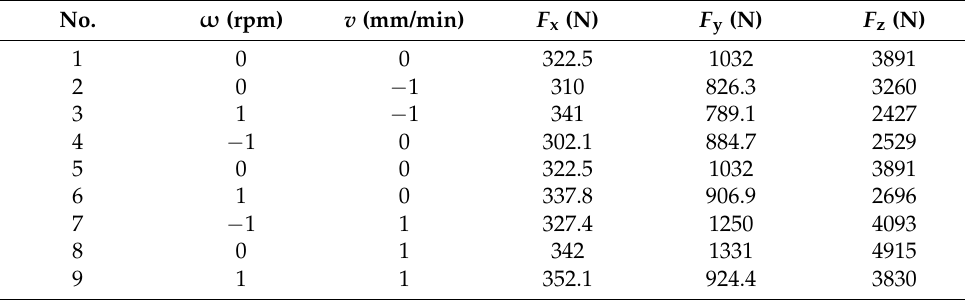
Table 4. Test results of matrix independent variables and their response